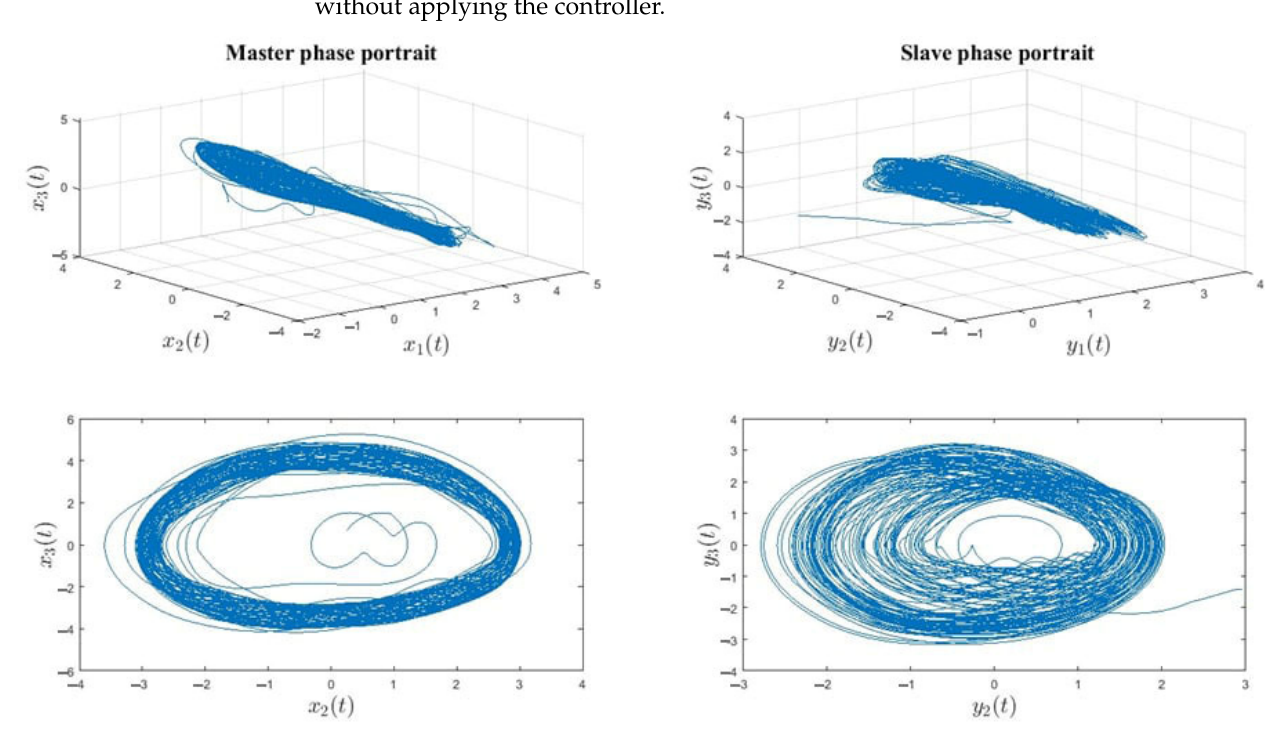
Figure 1. Phase diagram of the jerk master and slave systems without applying the controller.